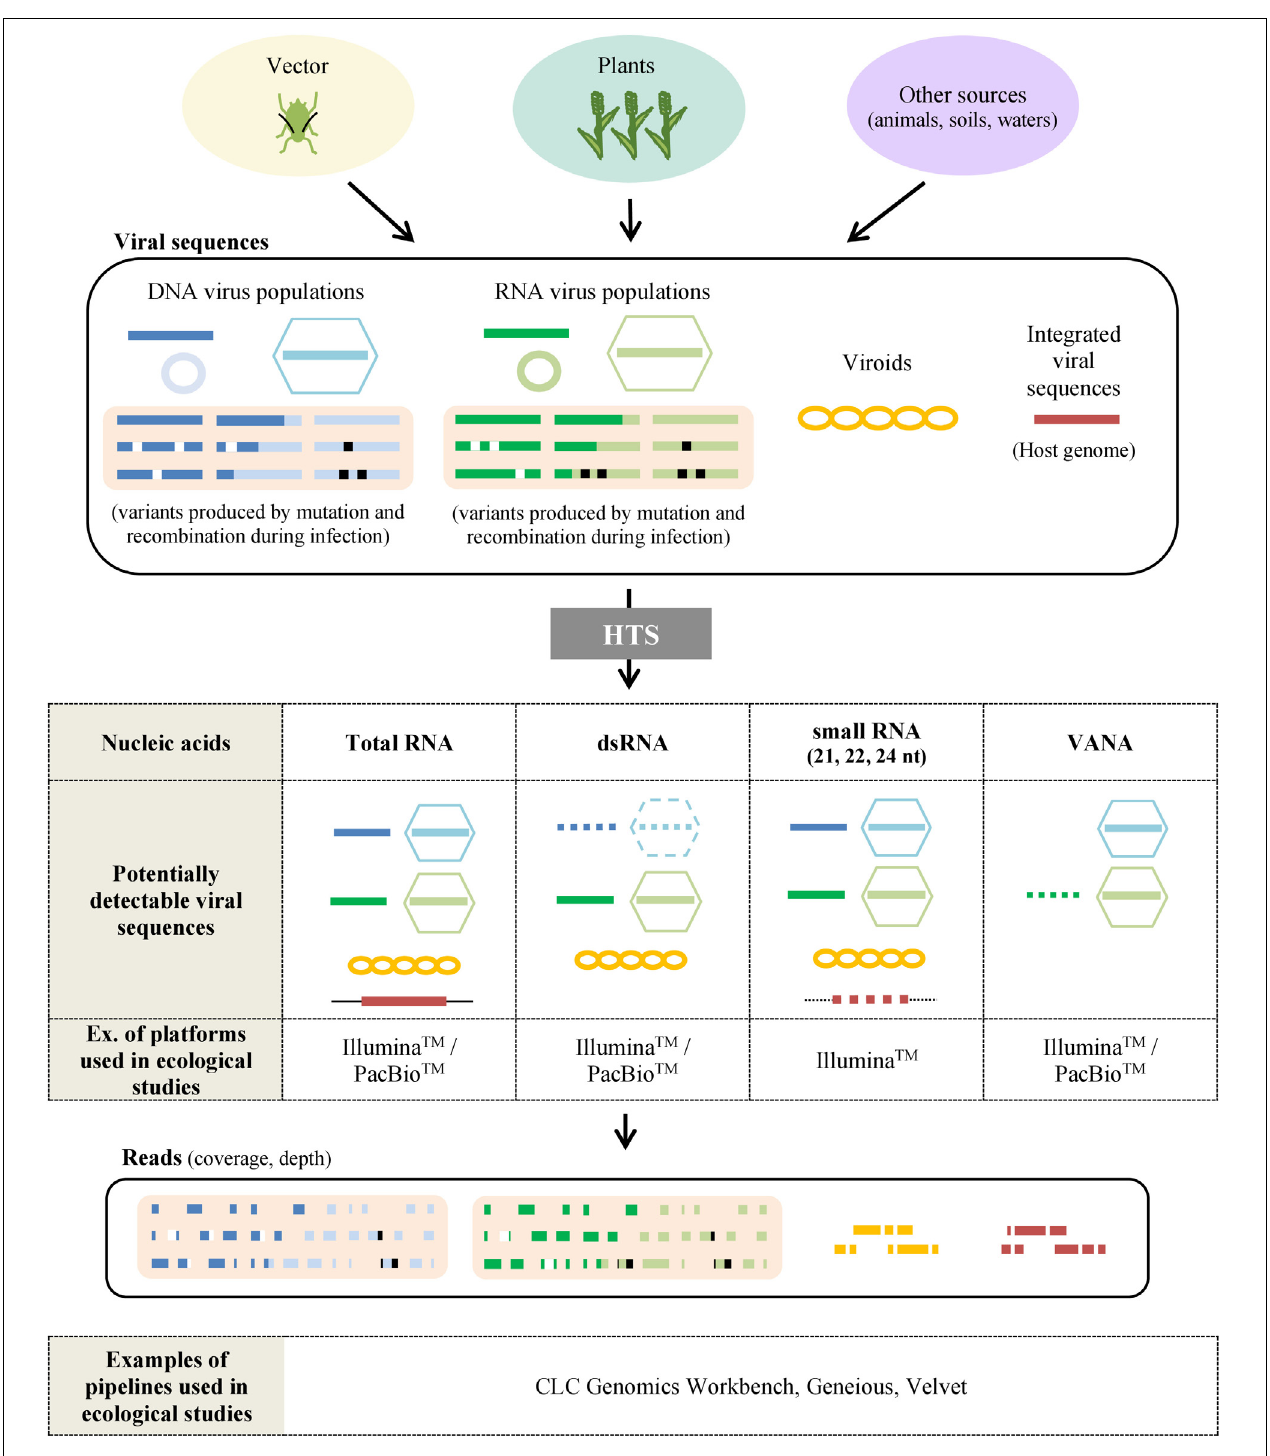
FIGURE 3 | Sample preparation for virus ecological studies using HTS. Samples taken from plants, vectors or other sources (waters, animals, etc.) may contain various viral sequences including DNA viruses (blue), RNA viruses (green), viroids (yellow) or viral sequences integrated in the host genome (red). Variants can be produced by mutations (white) and recombinations (black) during the infection. The most frequently used protocols to analyze viral sequences by HTS are based on the extraction of total RNA, dsRNA, small RNA, and Virion-Associated Nucleic Acids (VANA). By using sequencing platforms, sets of reads are obtained and have then to be processed by bioinformatic pipelines to reassemble them in order to detect, identify and quantify the virus and viroids present. Dotted figures correspond to viral sequences sometimes detected with the preparation method described.